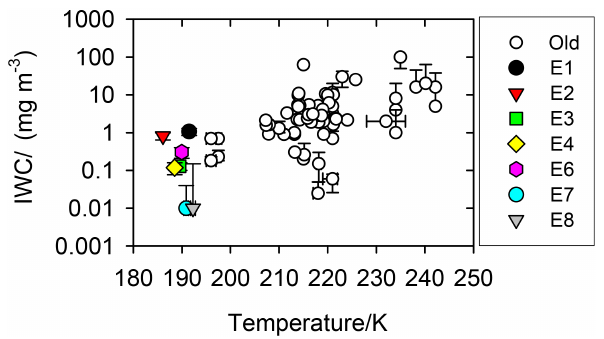
Figure 19. Ice water content (IWC) of contrails versus ambient tem- perature for various observations. Symbols as in Fig.